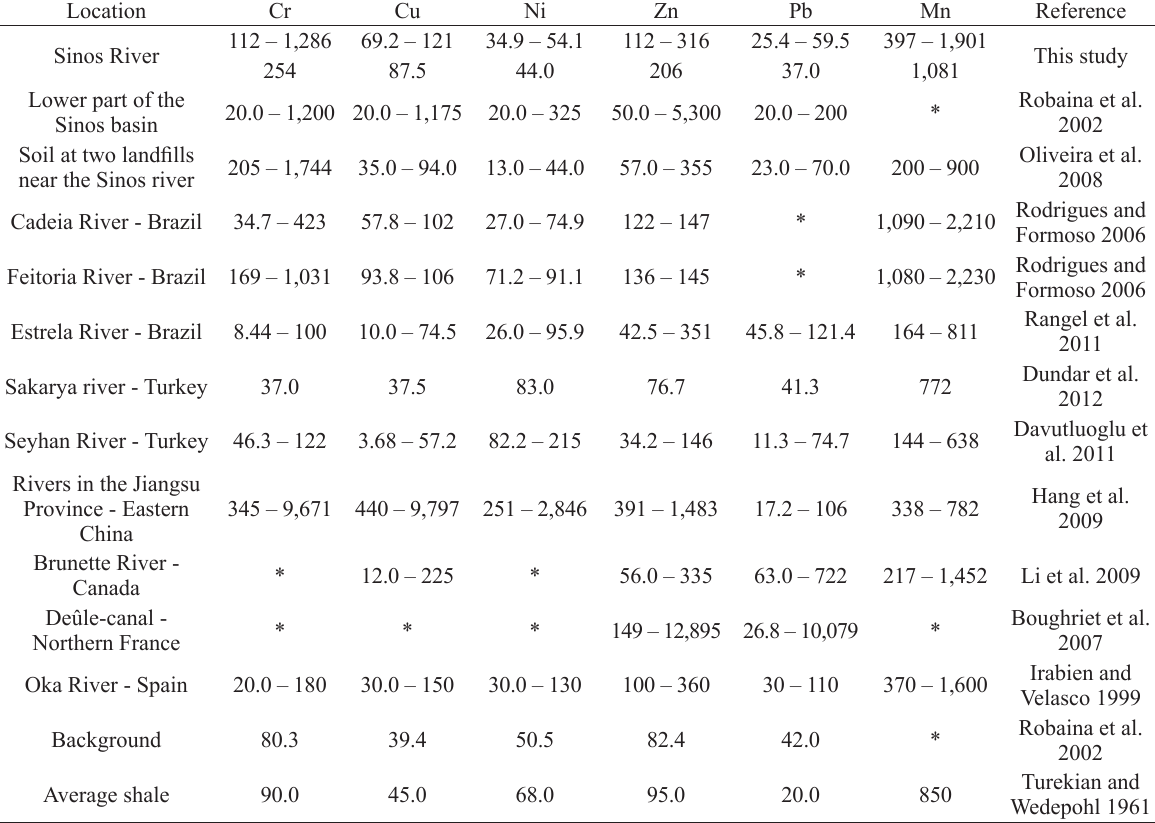
Metals concentration (mg/kg) in the study area (minimum- maximum) (average) compared with values from the